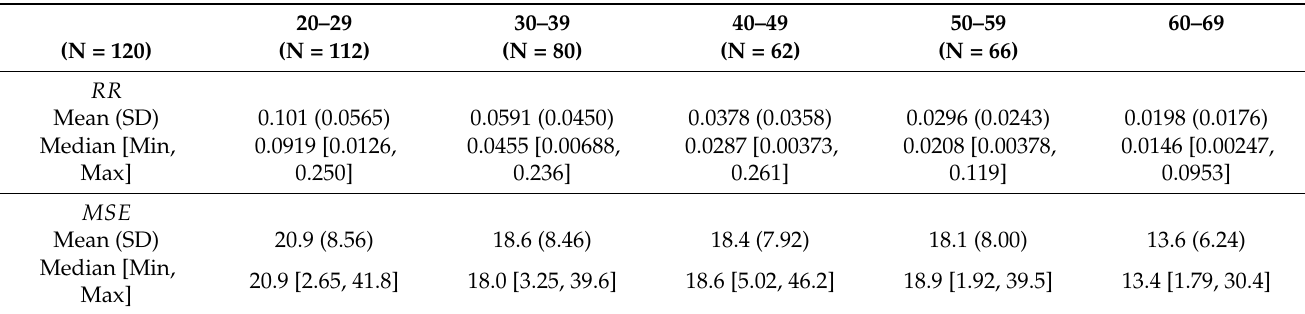
Table 2. Descriptive statistics of VAG parameters across age